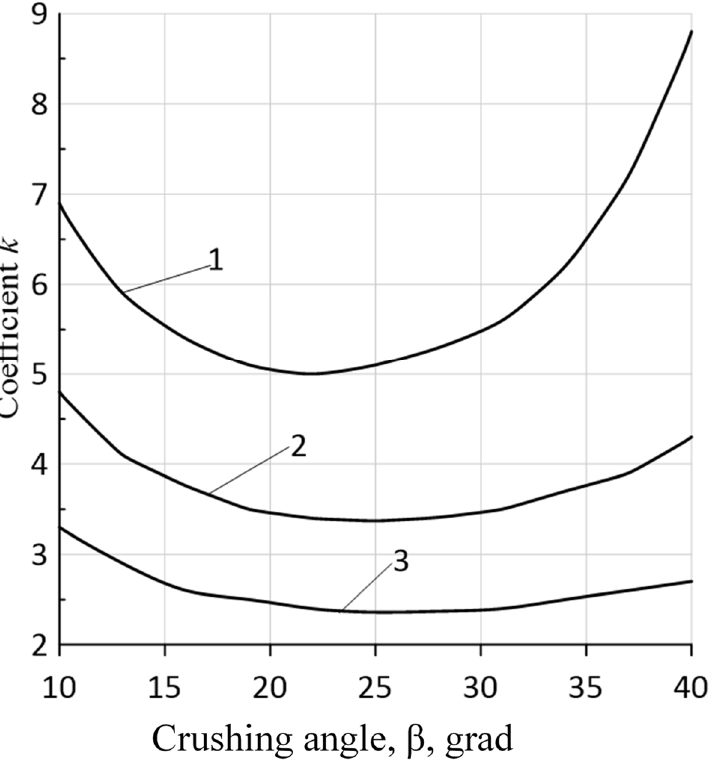
Figure 4. Dependence of the coefficient k on the crushing angle β of the skimmer at different values of the soil friction angle φ: 1—40°; 2—30°; 3—20°. of the soil friction angle ϕ : 1—40 ◦ ; 2—30 ◦ ; 3—20 ◦